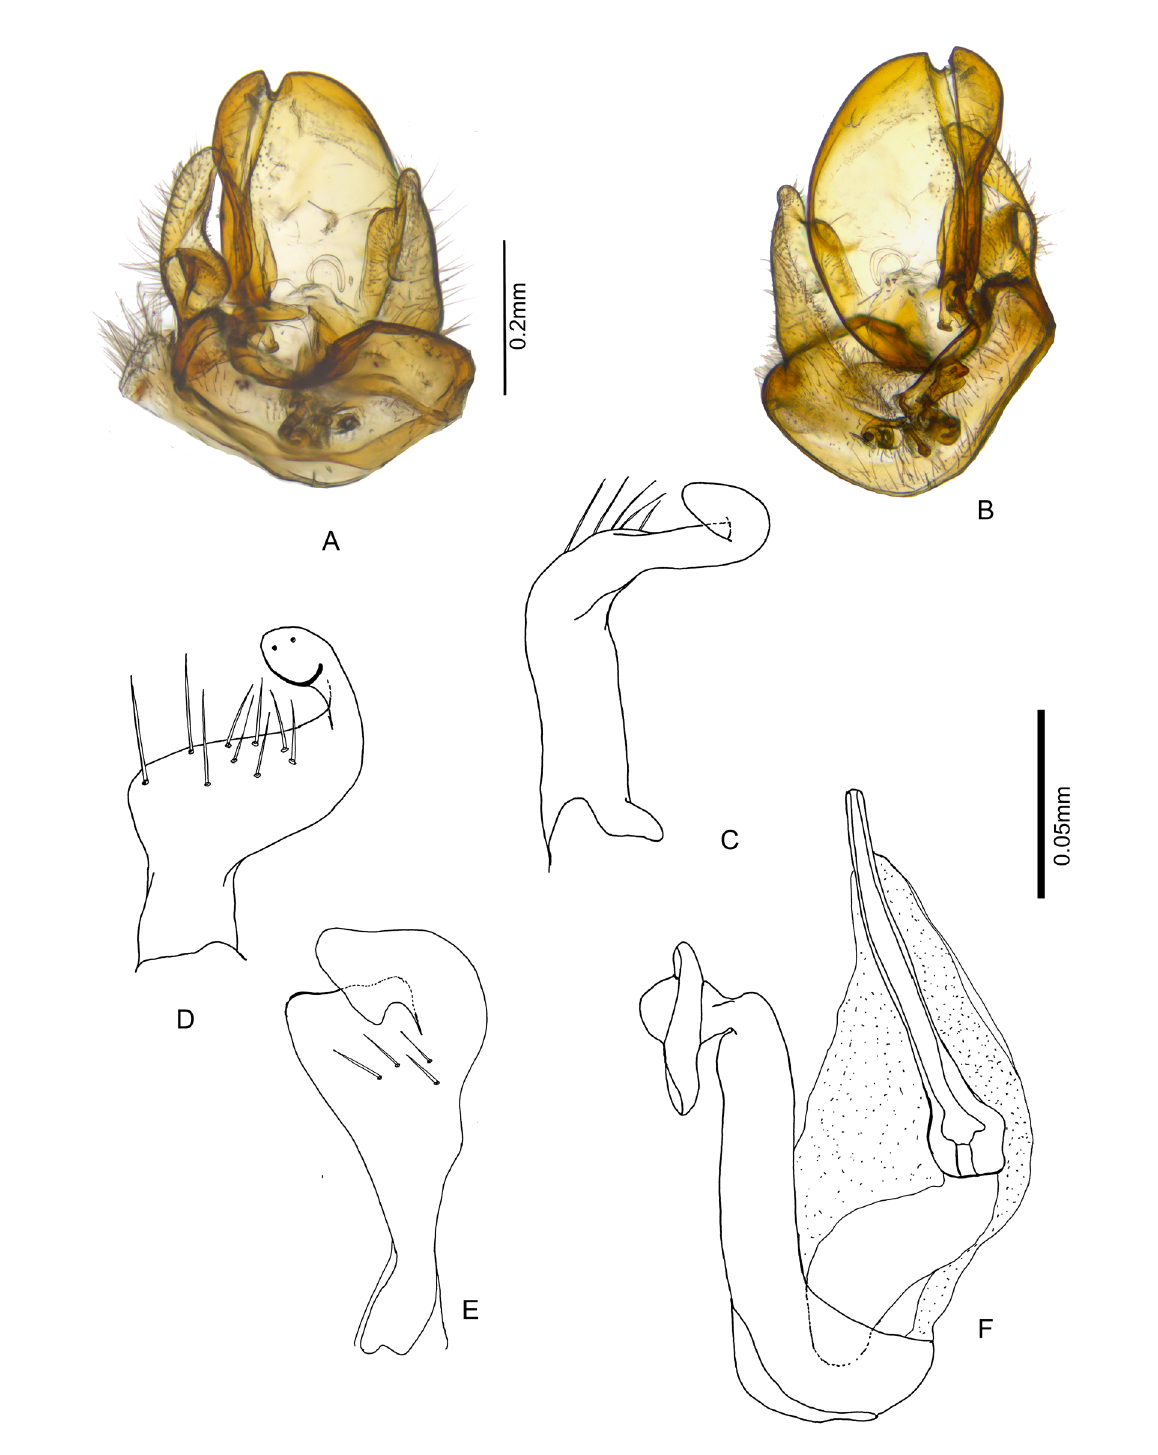
Fig. 18. Male genitalia of Lopidolon dandeliensis sp. nov., ♂, holotype, UASB. A–B . Genital capsule in dorsal and ventral views. C–D . Left paramere in lateral and dorsal views. E . Right paramere in dorsal view. F . Aedeagus in lateral